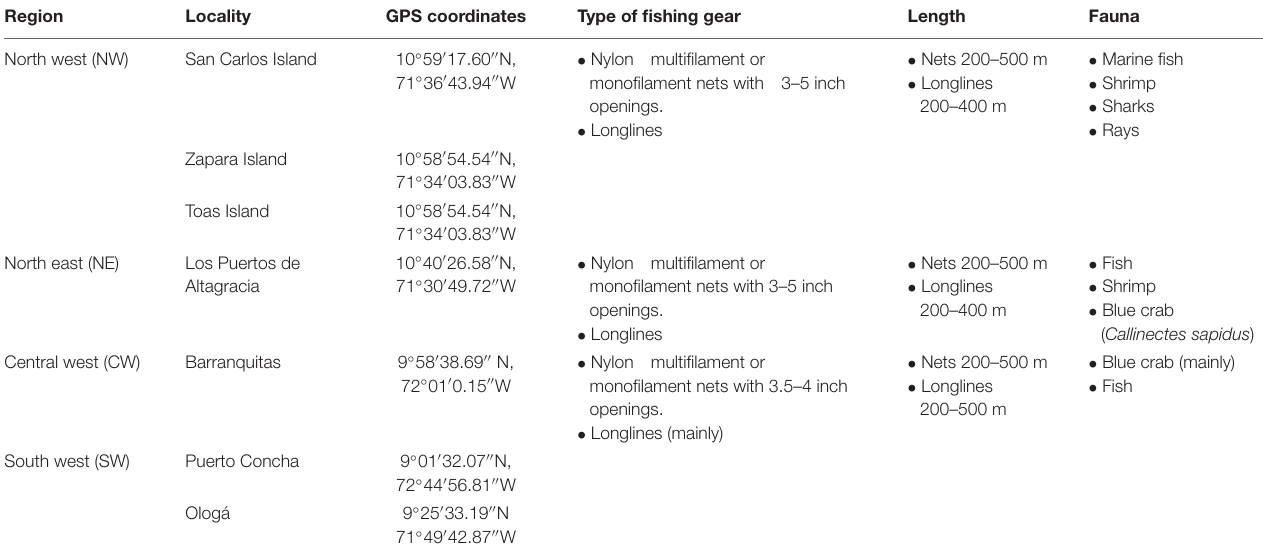
TABLE 1 | Localities evaluated in four regions of the Lake Maracaibo system. Region Locality GPS